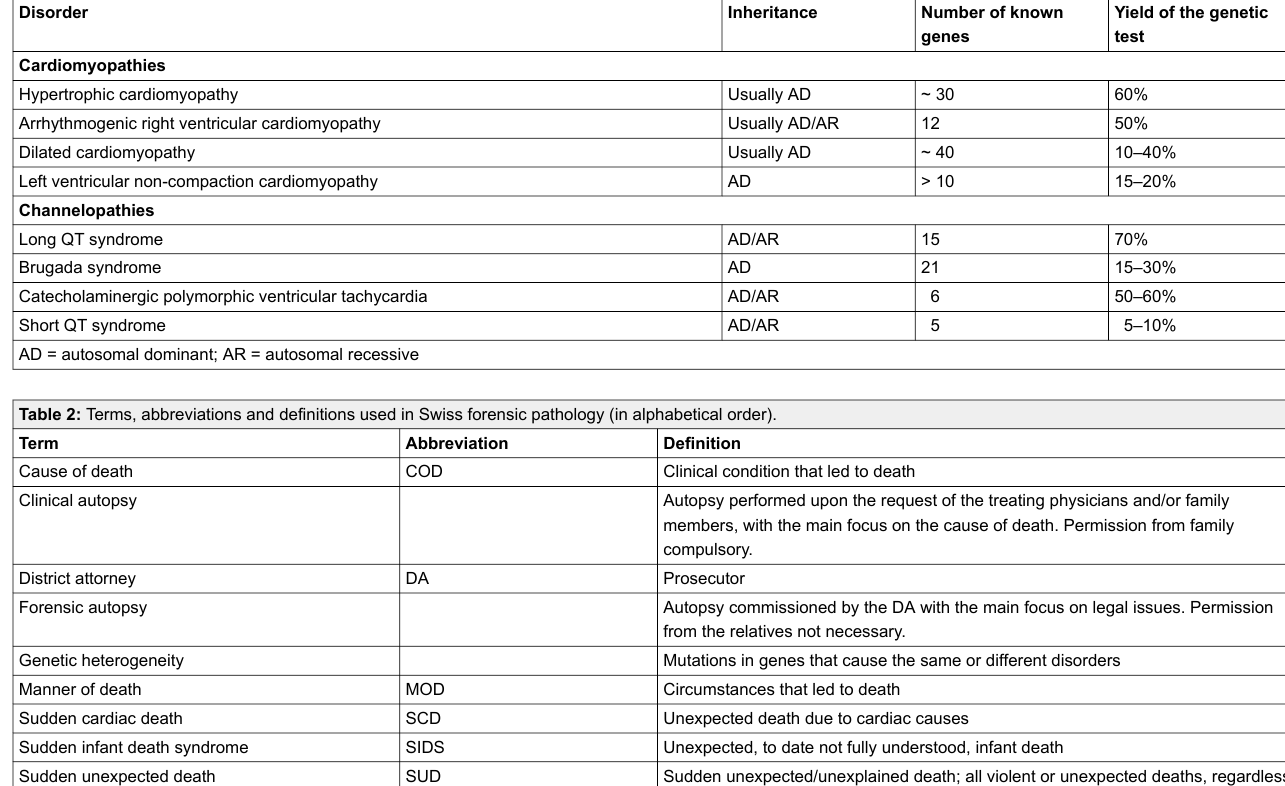
Table 1: Spectrum of the most frequent inherited cardiomyopathies and ion channel disorders (channelopathies) associated with sudden cardiac death. Disorder